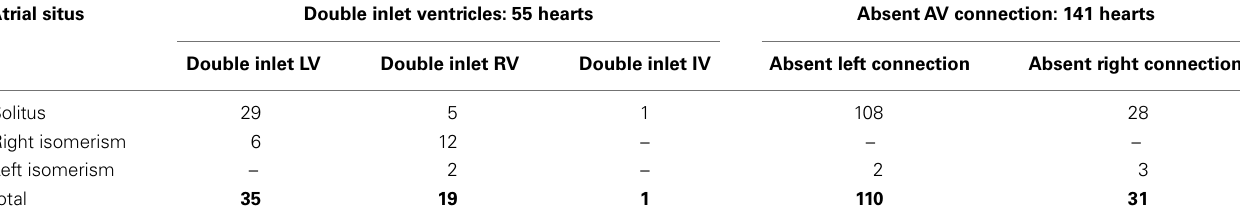
Table 1 | UniventricularAV connection: atrial situs . Atrial situs